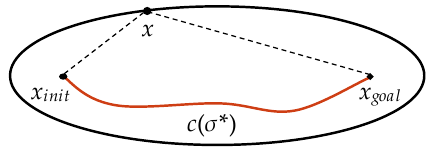
Figure 2. Hyper-ellipsoid of Informed-RRT*.